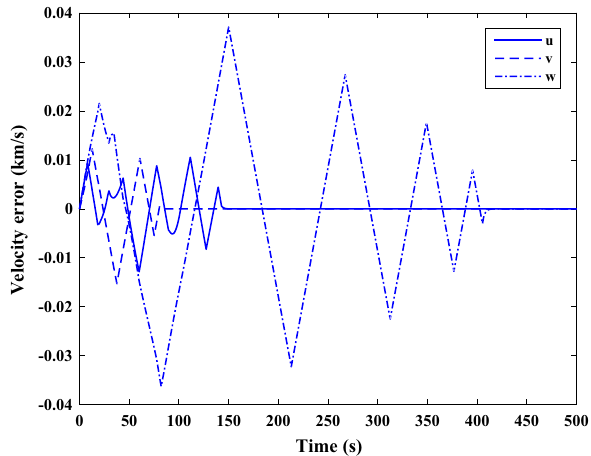
Figure 40. Scenario II: relative linear velocity error (in desired